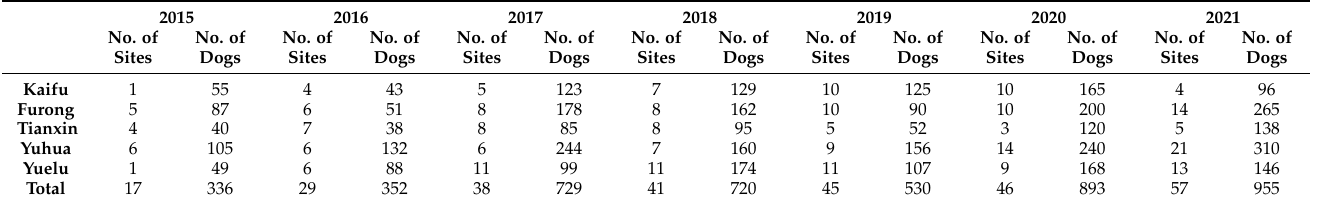
Table 1. Immunization points (No. of sites) and sample size (No. of dogs), Changsha, China,